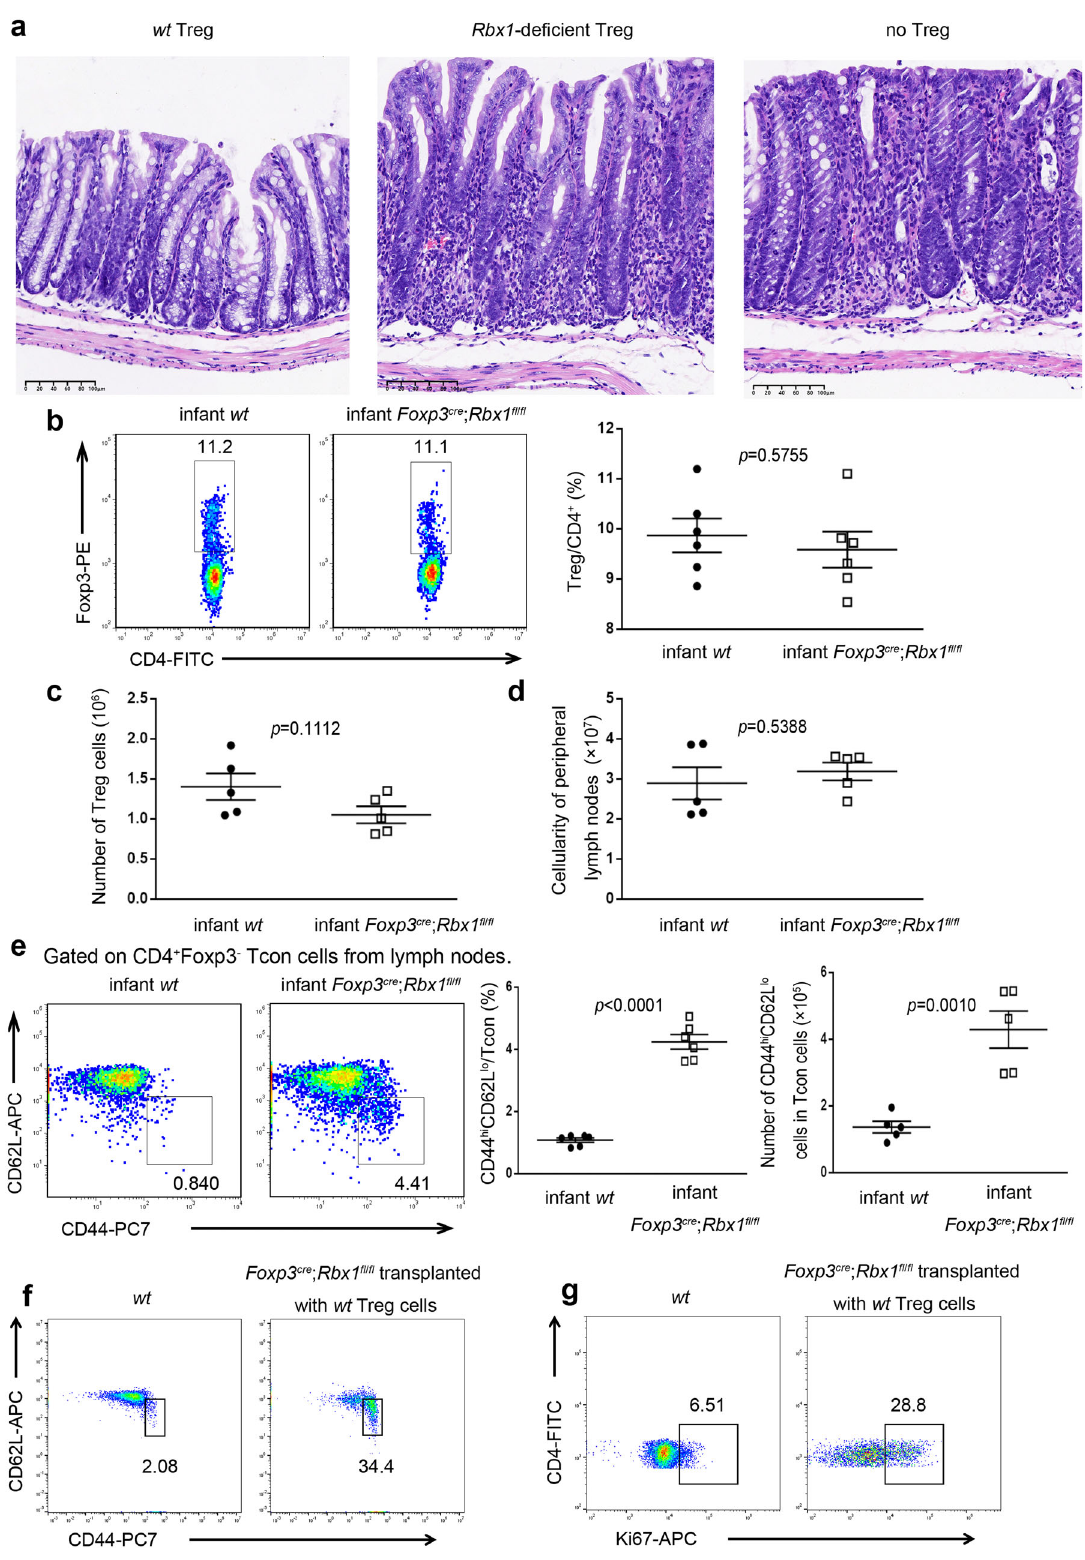
also used an alternative strategy to investigate the impairment of the immune suppressive function of Rbx1 -de fi cient Treg cells at early age. Compared to the wt control mice, Foxp3 cre ; Rbx1 fl / fl mice at the p8 stage have similar levels of Treg/CD4 + ratio (Fig. 2b), similar numbers of Treg cells, as well as total numbers of lymphocytes (Fig. 2c, d). However, these Treg Rbx1 -de fi